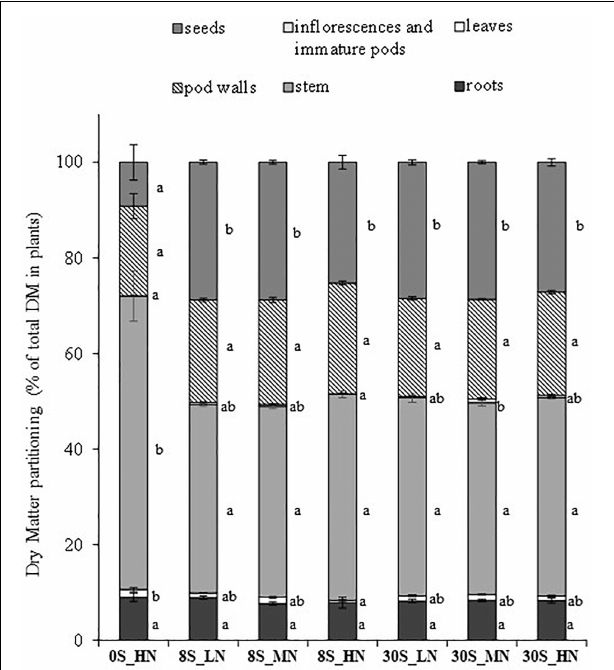
FIGURE 2 | DM partitioning (as % of total DM in plants) for different plant parts (roots, leaves, stems, inflorescence and immature pods, pod walls, and seeds) at harvest for plants grown under 0S_HN, 8S_LN, 8S_MN, 8S_HN, 30S_LN, 30S_MN, and 30S_HN conditions. Vertical bars indicate ± SE of the mean ( n = 5, n = 6 for 8S_LN). Different letters indicate that mean values are significantly different ( p < 0.05) between treatments for the different plant